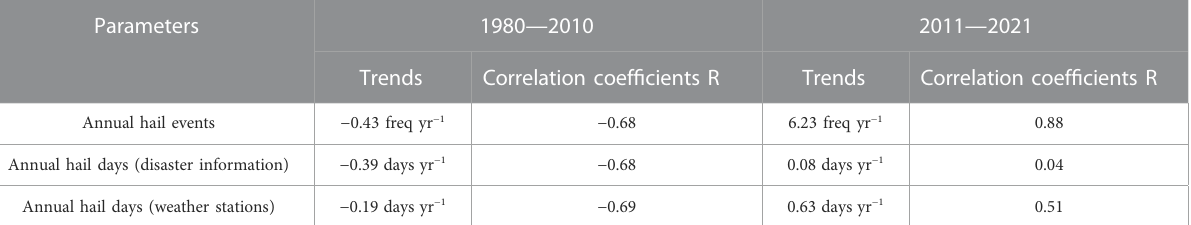
TABLE 2 Trends of hail parameters from different sources and the related correlation coef fi cients in the time periods of 1980 – 2010 and 2011-2021,